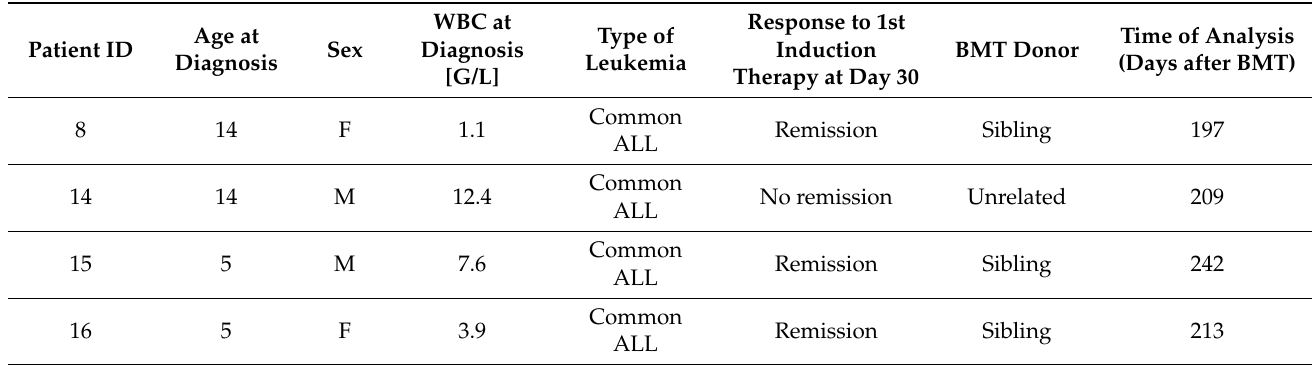
Table 1. Clinical characteristics of hematopoietic stem cell transplantation recipients.